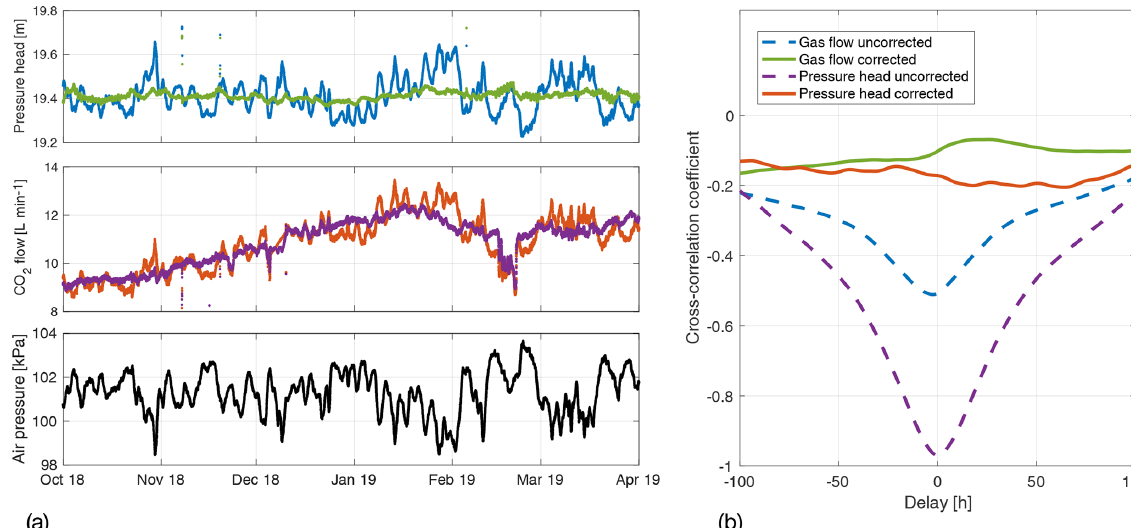
Figure 7. The barometric effect to the pressure head and CO 2 flow in the Hartoušov F1 borehole for the period from October 2018 to April 2019. (a) Original measurements are indicated in blue, and those corrected for barometric pressure are in red. The upper panel shows pressure head at the depth below the bubble formation, and the lower panel shows gas flow measured by flowmeter. The success of barometric correction is illustrated in (b) showing the decrease in barometric anticorrelation after